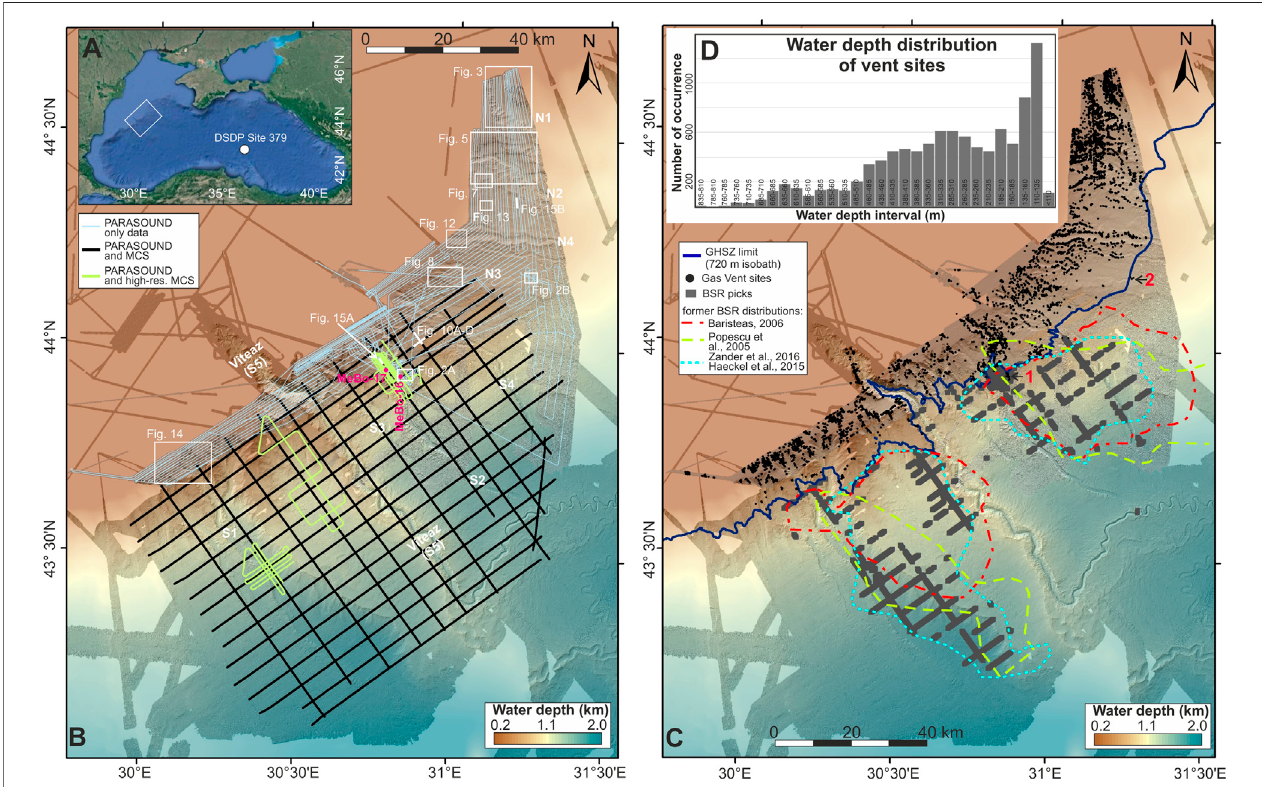
FIGURE 1 | (A) Study region of expeditions MSM34, M142, and M143 (white rectangle) in the western Black Sea. (B) Sea fl oor bathymetry of the study region and outline of data utilized in this study with naming of channel systems. Following Winguth et al. (2000) the S1 – S4 channels are linked to the Danube fan and the N1 – N4 channels are linked to the Dnepr fan. Location of areas studied in detail in this study are indicated by white rectangles. (C) Sea fl oor bathymetry overlain with location of gasseeps.Theseismicallydeterminedbottom-simulatingre fl ector(BSR)occursexclusivelydeeperthan720 mwhichistheinferredlimitofthegashydratestability zone (GHSZ). In comparison, earlier outlines of BSR-distributions are shown. Two sites of gas venting deeper than the 720 m isobath (labeled in red) are linked to vent sites with gas hydrate occurrences. (D) Histogram of the water depth distribution of all vent sites mapped in the region. Water depth at the vent site locations was taken from the newly acquired bathymetry of expeditions M142 and